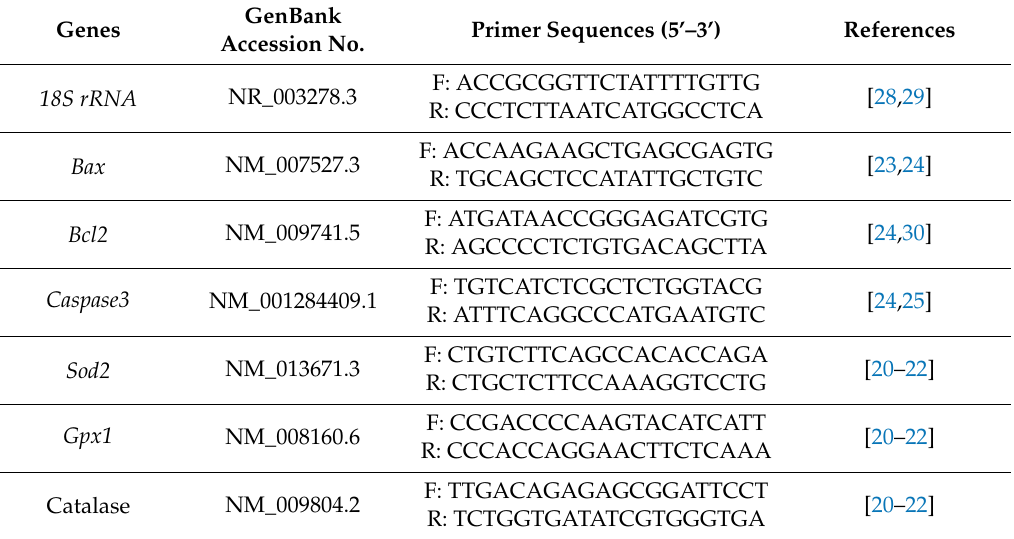
Table 1. Primer sequences for real-time polymerase chain reaction.